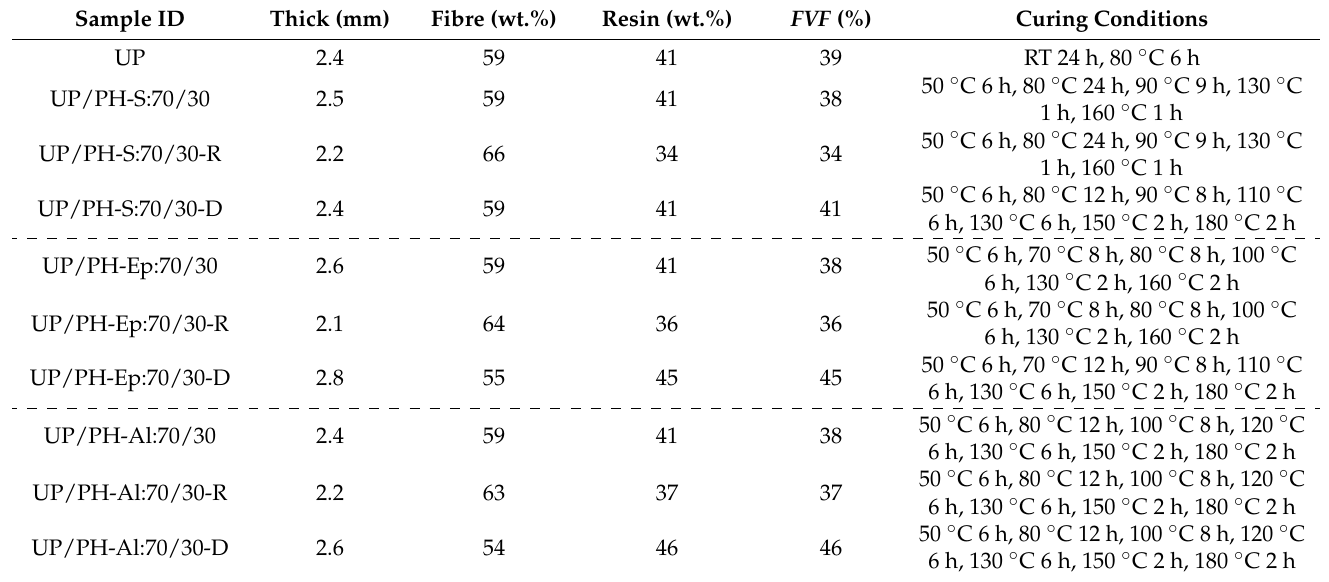
Table 1. Composition of the GFRC from UP and UP/PH blends with